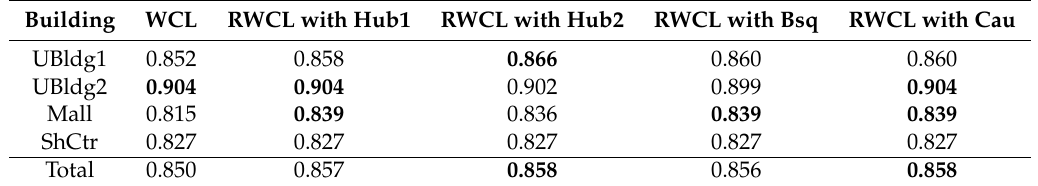
Table 3. Comparison of the floor detection probability for different Weighted Centroid Localization (WCL) approaches. Column 2 shows the basic approach, columns 3 to 6 are the robust WCL approach with various robust functions: Hub1 (Huber with tuning coefficient k = 1.345), Hub2 (Huber with tuning coefficient k = 0.9), Bsq (Bi-square with tuning coefficient k = 4.685), and Cau (Cauchy with k = 2.385). The highest probability in each row has been shown in Bold. All of the robust methods outperform the ordinary WCL.